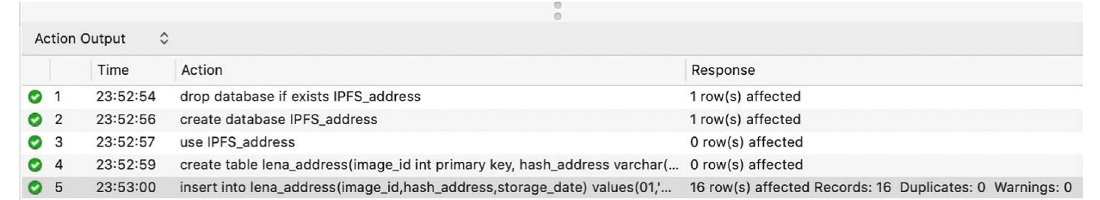
Figure 4. The result feedback of adding address into database.